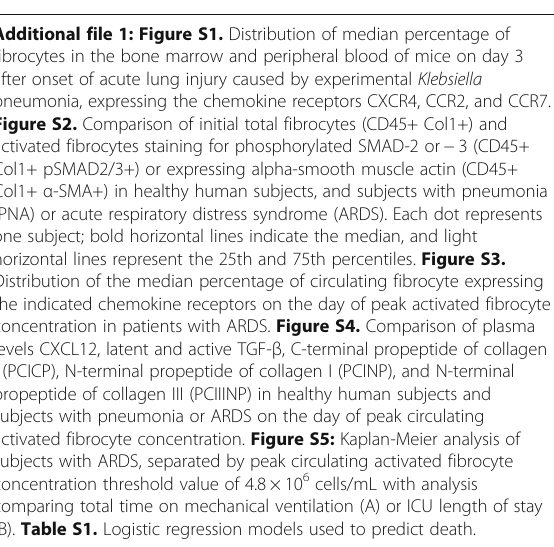
Additional file 1: Figure S1. Distribution of median percentage of fibrocytes in the bone marrow and peripheral blood of mice on day 3 after onset of acute lung injury caused by experimental Klebsiella pneumonia, expressing the chemokine receptors CXCR4, CCR2, and CCR7. Figure S2. Comparison of initial total fibrocytes (CD45+ Col1+) and activated fibrocytes staining for phosphorylated SMAD-2 or − 3 (CD45+ Col1+ pSMAD2/3+) or expressing alpha-smooth muscle actin (CD45+ Col1+ α -SMA+) in healthy human subjects, and subjects with pneumonia (PNA) or acute respiratory distress syndrome (ARDS). Each dot represents one subject; bold horizontal lines indicate the median, and light horizontal lines represent the 25th and 75th percentiles. Figure S3. Distribution of the median percentage of circulating fibrocyte expressing the indicated chemokine receptors on the day of peak activated fibrocyte concentration in patients with ARDS. Figure S4. Comparison of plasma levels CXCL12, latent and active TGF- β , C-terminal propeptide of collagen I (PCICP), N-terminal propeptide of collagen I (PCINP), and N-terminal propeptide of collagen III (PCIIINP) in healthy human subjects and subjects with pneumonia or ARDS on the day of peak circulating activated fibrocyte concentration. Figure S5: Kaplan-Meier analysis of subjects with ARDS, separated by peak circulating activated fibrocyte concentration threshold value of 4.8× 10 6 cells/mL with analysis comparing total time on mechanical ventilation (A) or ICU length of stay (B). Table S1. Logistic regression models used to predict